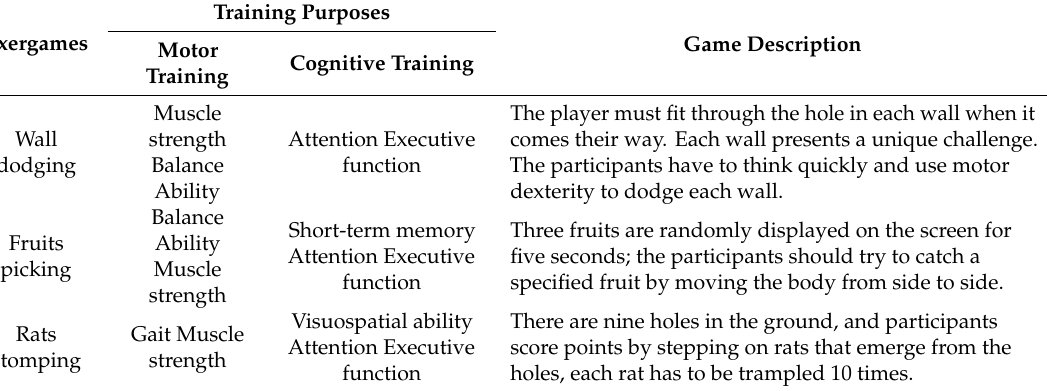
Table 1. Exergames based on cognitive–motor intervention